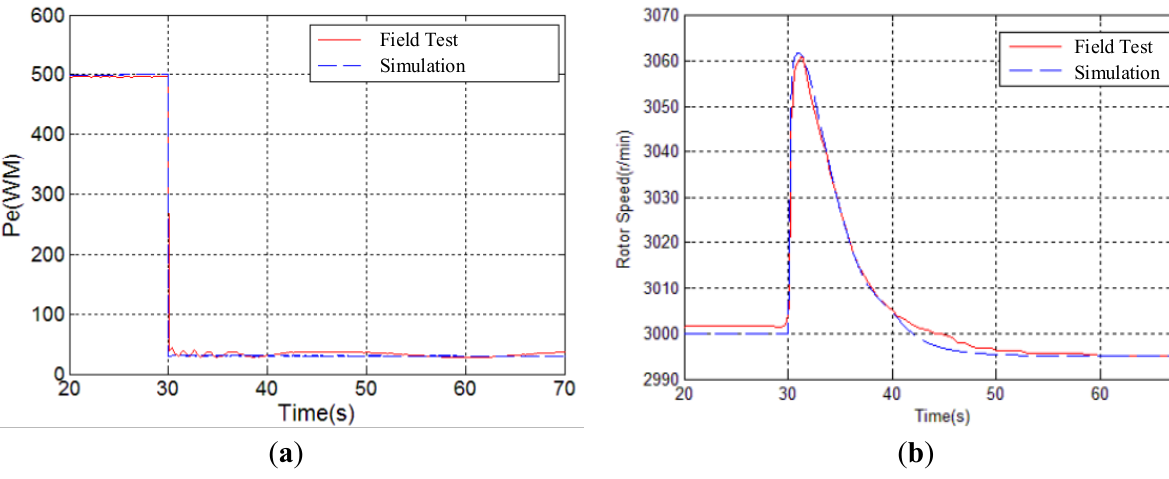
Figure 15. Waveform comparison of: ( a ) P